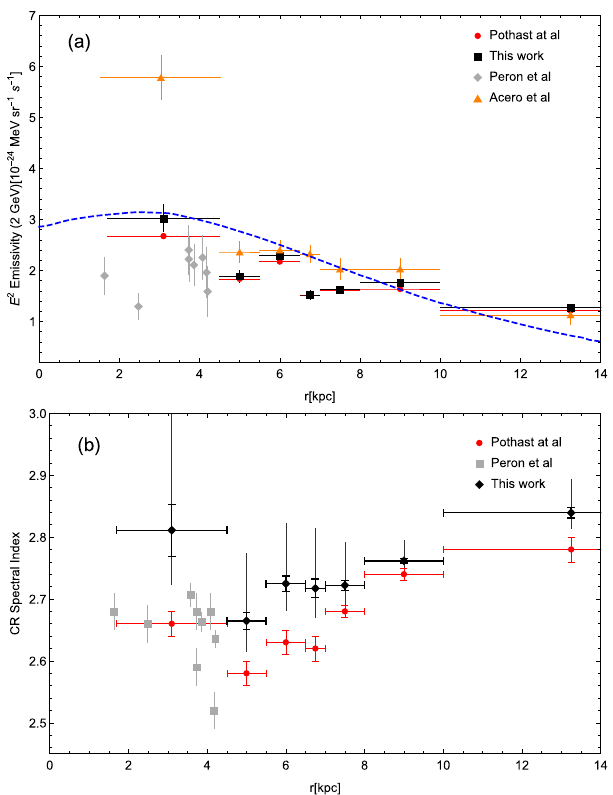
Fig. 3 Gamma-rays emissivity and cosmic ray proton spectral index in different galactocentric rings. The gamma-ray emissivity ( a ) and the cosmic ray spectral index ( b ) obtained in this work (black points) compared with the ones in Peron et al. 29 (gray points), Pothast et al. 2 and in Acero et al. 4 (orange points). The error bars for black points are obtained by summing in quadrature statistical and systematical uncertainties, see Table 2. In particular, thin error bars show the systematic uncertainties conservatively estimated by varying the spectral parameters in our phenomenological model, while thick error bars only include statistical uncertainties in the fi tting procedure. The blue dashed line represents the CR distribution predicted by the GALPROP code 30 normalized at 8.5 kpc at the emissivity value obtained in this work in the ring 8 – 10